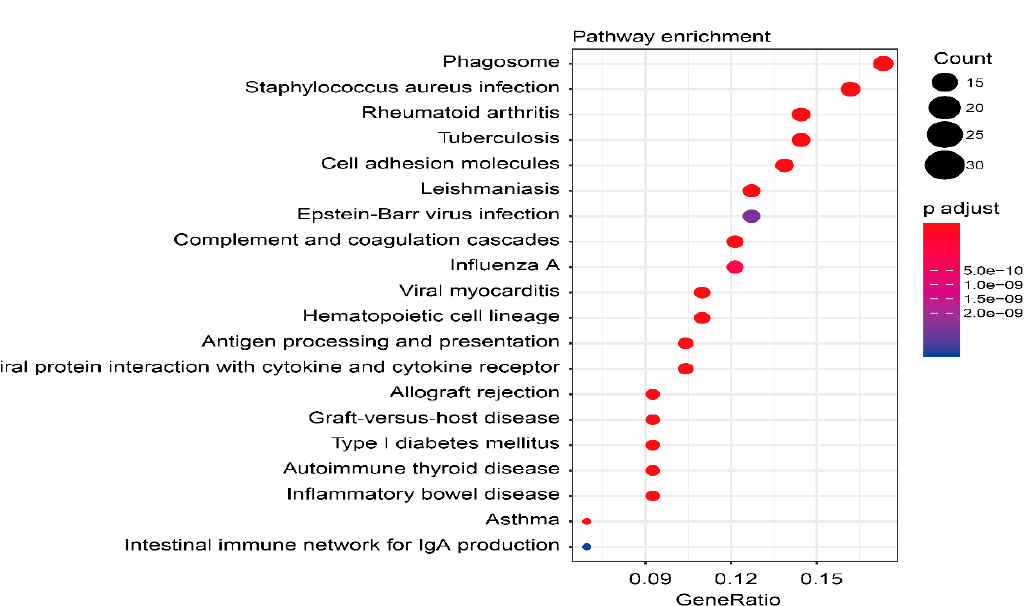
Figure 15. GO enrichment analysis of 271 TME-related subtype genes, with the 10 most significant functions in each panel.